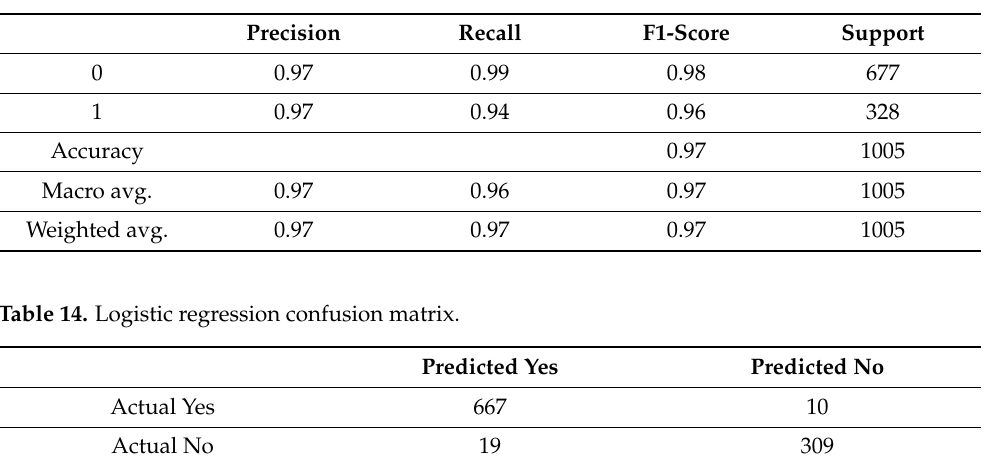
Table 13. Logistic regression classification report.